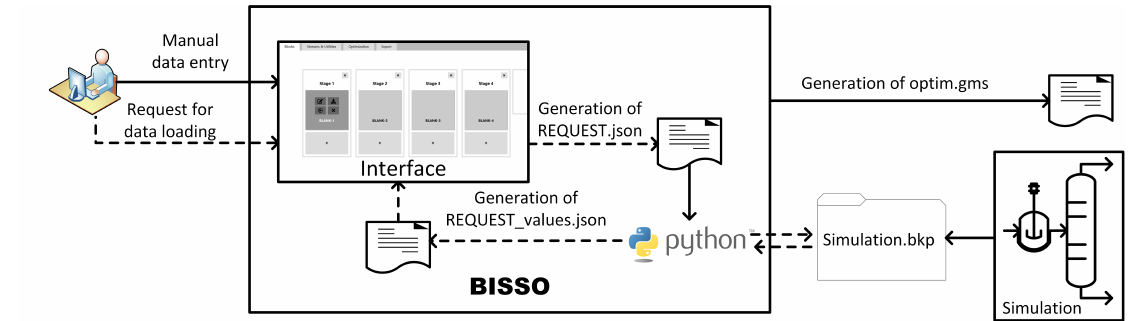
Figure 2. Scheme of the flow of information within the tool. Flow for uploading data from already run Aspen Plus (.bkp) files is shown in dashed lines.